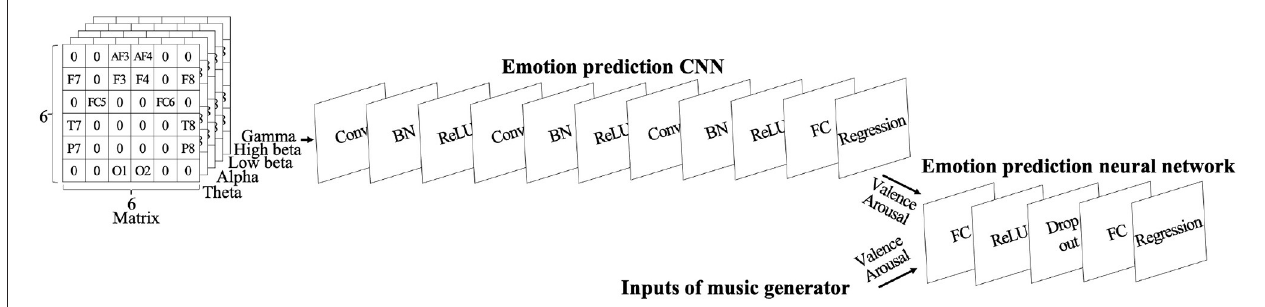
FIGURE 1 | Model structure: Upper part is a CNN that predicts emotion from EEG data. Right part is a neural network that uses predicted emotions from CNN and music generator’s inputs for emotion